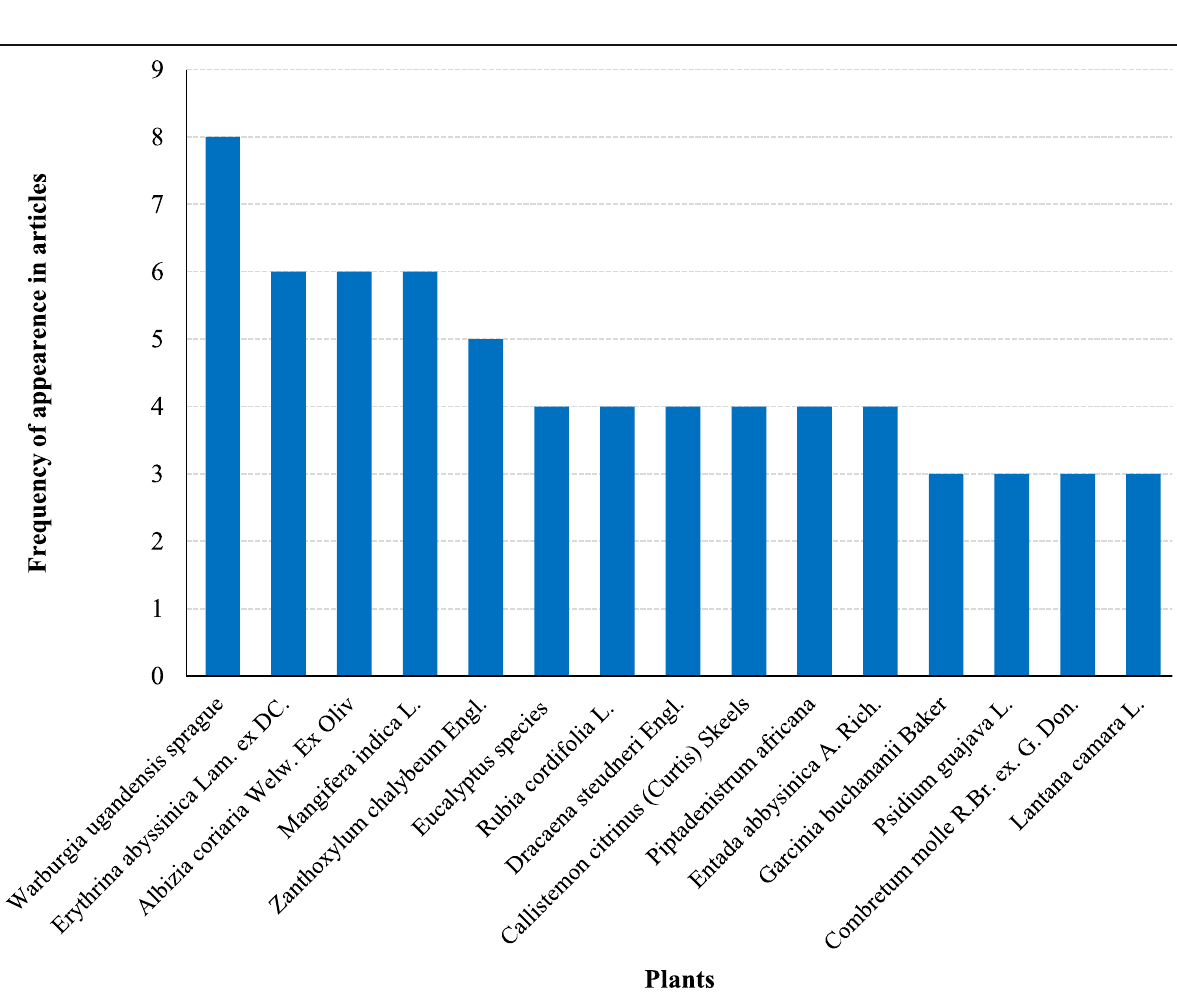
Fig. 2 The most cited plant species used for treatment of TB and its symptoms in East Africa